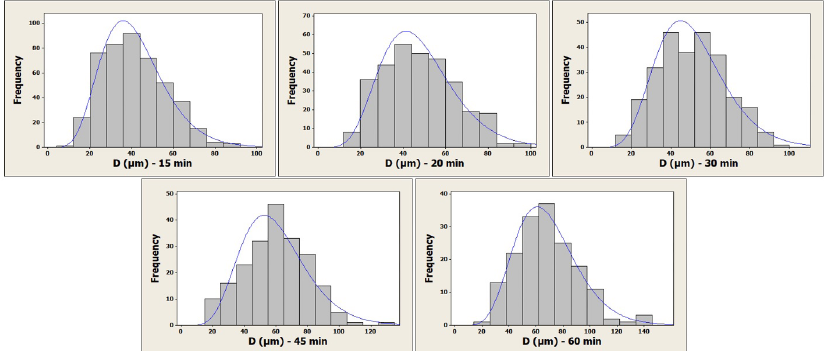
Figure 13. Particle size frequency distribution of the ZA27-2%Cu-0.015%Mg alloy during the heat treatment. Adjusted to Gamma distribution.